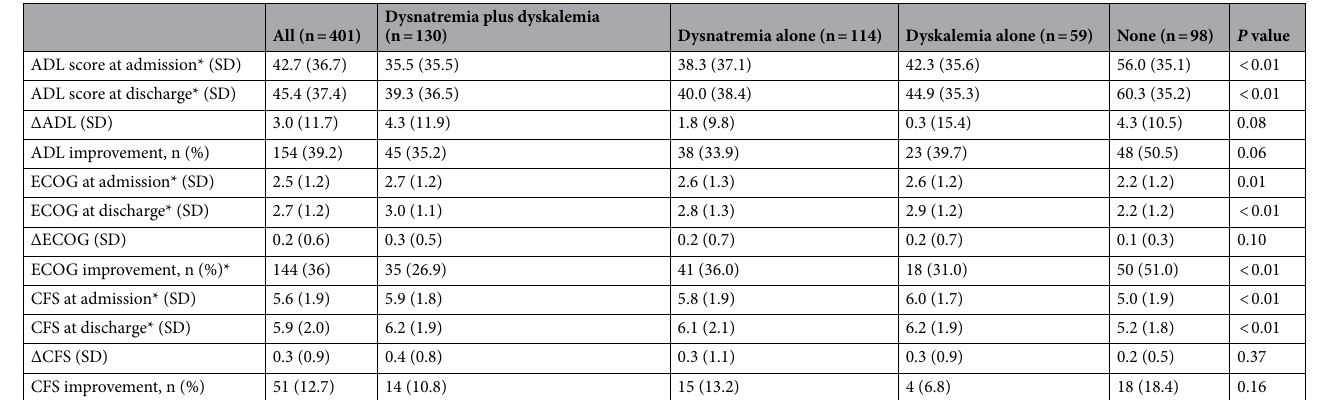
Table 2. Functional status changes of the study population with or without dysnatremia and dyskalemia during hospitalization. ADL activities of daily living, SD standard deviation, ECOG eastern cooperative oncology group, CFS clinical frailty score. * P < 0.05.